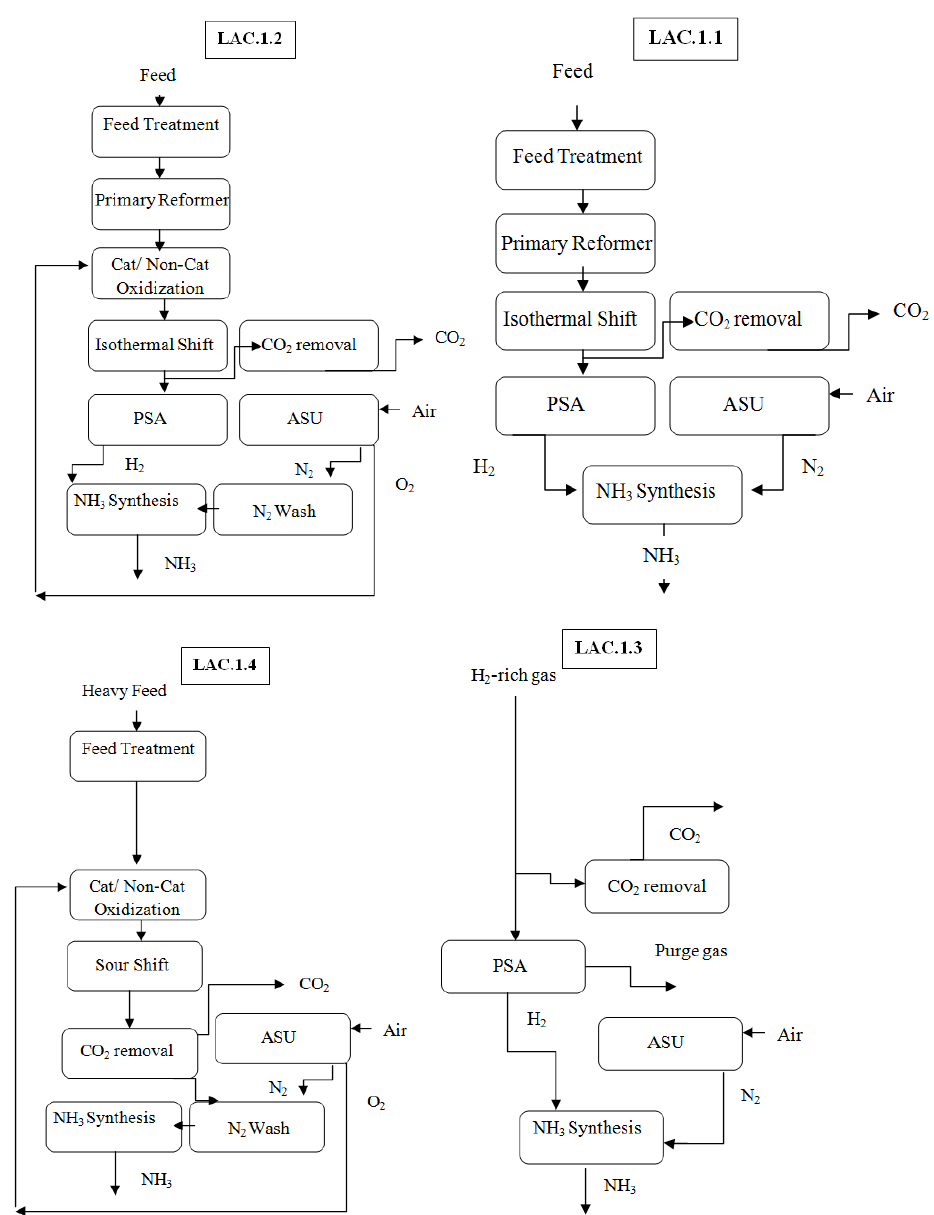
Figure 11. Linde–Ammonia Concept categories, reproduced from Reference [34].